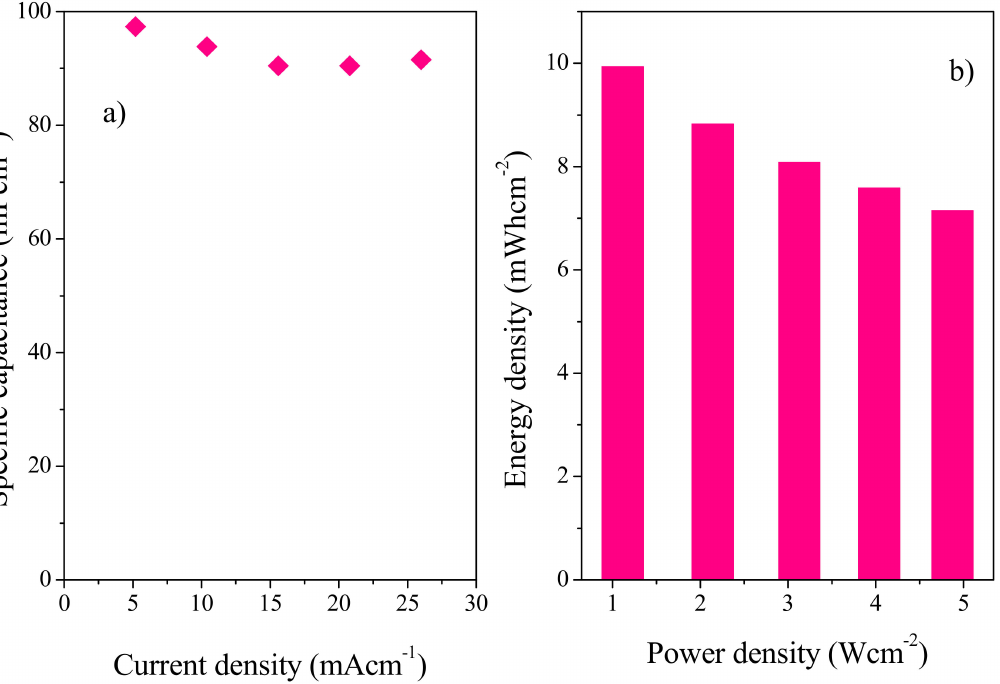
Figure 11. ( a ) Dependence of specific capacitance of the solid-state symmetric device, fabricated with gold as current collector, on current density. ( b ) The Ragone